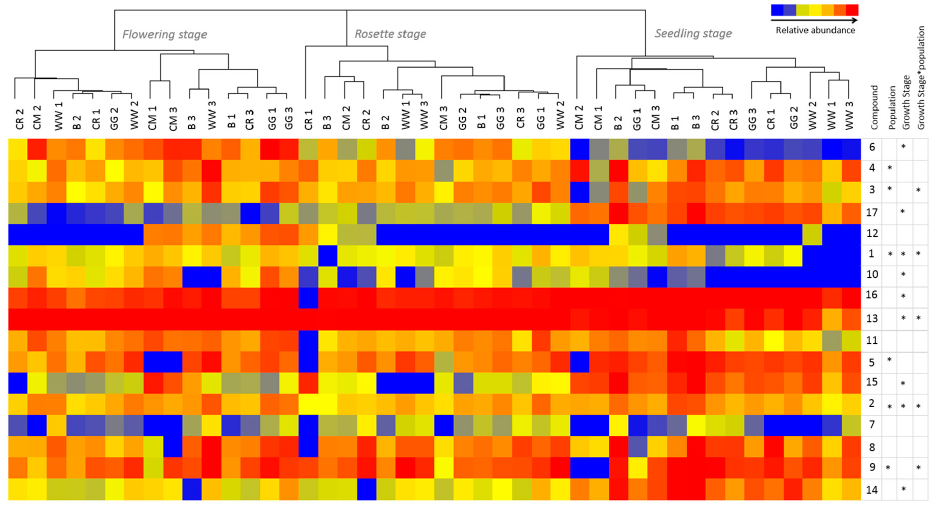
Figure 4. Relative abundance of 1–17 PANOs (Table 1) in extracts of five populations of Echium plantagineum harvested at three growth stages in controlled conditions experiment. Hierarchical clustering was performed using MPP Software on normalized values and Euclidean distance metric. *–denotes significance of population, growth stage and their interaction (repeated measures ANOVA; p < 0.05). Key to populations: B–Bendigo, CM—Coombah, CR—Cobar, GG—Gol Gol, WW—Wagga Wagga (numbers indicate block of replication).